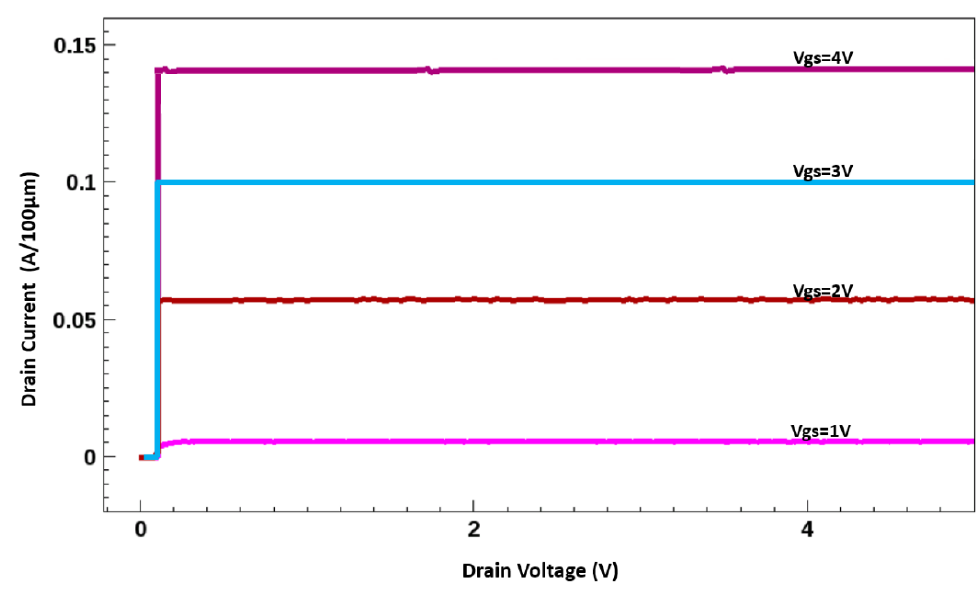
Figure 8. IV Curve with different Vgs ramping AlGaN/GaN HEMT.